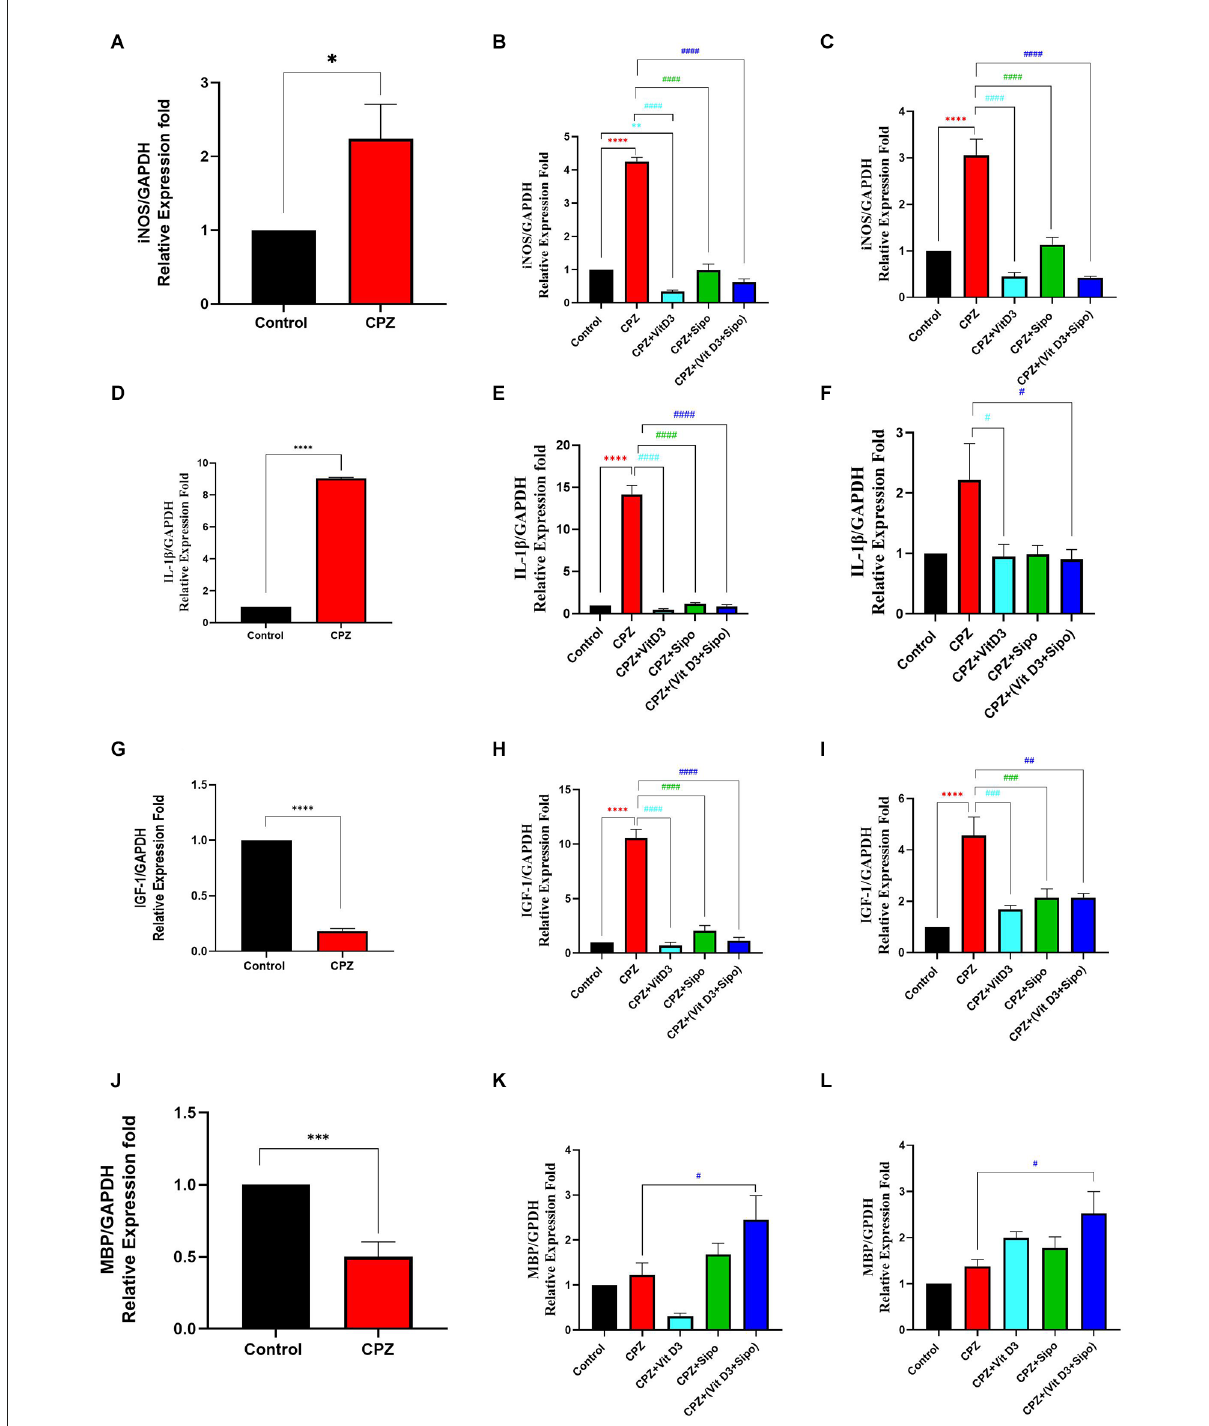
FIGURE8 mRNA expression level of iNOS, IL-1 β , IGF-1, and MBP in the CC. (A,D,G,J) Effects of CPZ on relative expression level of iNOS, IL-1 β , IGF-1, and MBP in the CC of mice during demyelination stage, respectively. (B,C,E,F,H,I,K,L) Effects of Vit D3 and Sipo on relative expression level of iNOS, IL-1 β , IGF-1, and MBP in the CC of mice during early and late remyelination stages, respectively. Data are represented as means ± SEM and t-test was used in (A,D,G,J) and One-way ANOVA followed by Tukey’s test was used in (B,C,E,F,H,I,K,L) . iNOS, inducible nitric oxide synthase; IL-1 β , interleukin 1 beta; IGF-1, insulin-like growth factor 1; MBP, myelin basic protein; GAPDH, glyceraldehyde-3-phosphate dehydrogenase; CPZ, cuprizone; Vit D3, vitamin D3; Sipo, siponimod. ( ∗ ) Indicates a significant difference vs. the control group; ( # ) indicates a significant difference